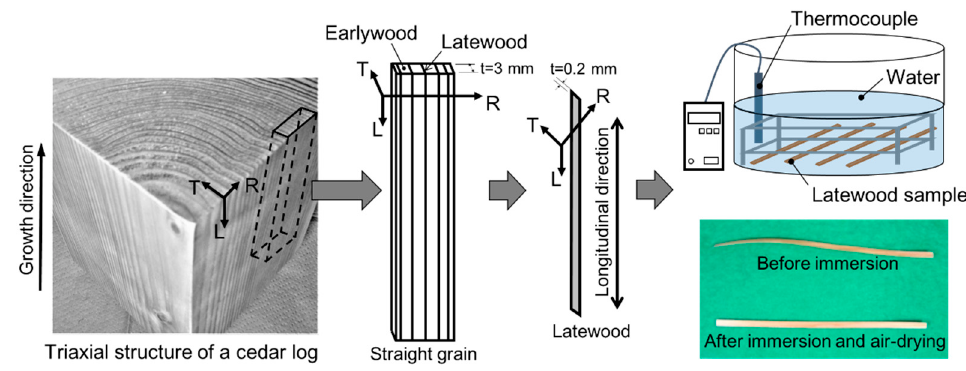
Figure 3. Manufacturing process and orientation of the latewood tensile specimen. Microstructures of the latewood specimen in two orientations, T-R plane (a) and L-T plane (b), are shown in Figure 4. Tracheids with square or slightly rectangular cells of differing thickness were observed in the T-R plane. The thickness of the cell wall of tra- cheids ranged from 1 to 5 μ m. The other region (three broken-line frames) running from the top to the bottom of the microstructure was the ray tissue. The tracheids and ray cells had a specific tilt angle, θ to the L direction in the L-T plane (b). The range was approxi- mately 0 to 20°, measured by a protractor qualitatively. The density and MC in the late- wood specimen measured by [37] were 897 kg/m 3 and 10%, respectively.